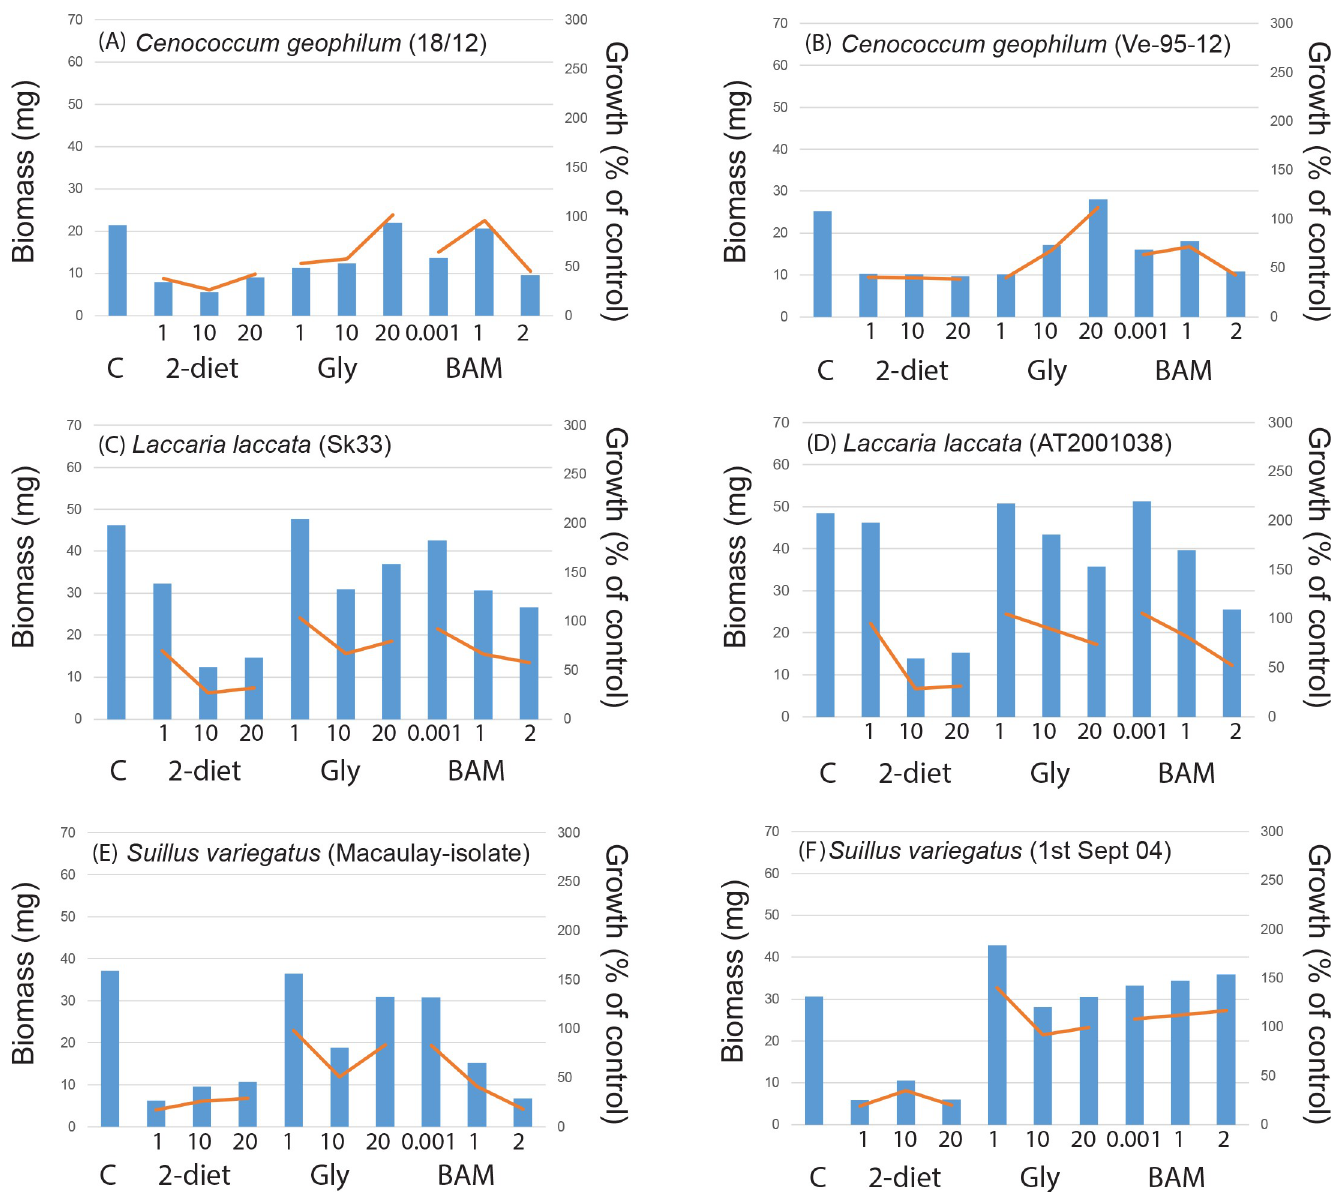
Fig 3. Intra-specific mycorrhizal fungal growth responses to recalcitrant amine, amide and ammonium containing media similar among isolates. The intra- specific variation (n = 2 isolates per species) in biomass responses to treatments compared to controls (C, n = 2) for mycorrhizal fungal species in a screening experiment including 2-diethylaminoethanol (2-diet), N 3 -Trimethyl(2-oxiranyl)methanaminium chloride (gly) and BAM at three different concentrations (n = 1 for each treatment). For 2-diethylaminoethanol and N 3 -Trimethyl(2-oxiranyl)methanaminium chloride concentrations were 1, 10, and 20 g L -1 , respectively. For BAM 1 μ L, 1 mL, and 2 mL of a saturated solution was added. Bars show biomass (mg), lines show growth as a percentage of the growth controls: (A) and (B) Cenococcum geophilum , (C) and (D) Laccaria laccata , (E) and (F) Piceirhiza bicolorata , and (G) and (H) Suillus variegatus , respectively.